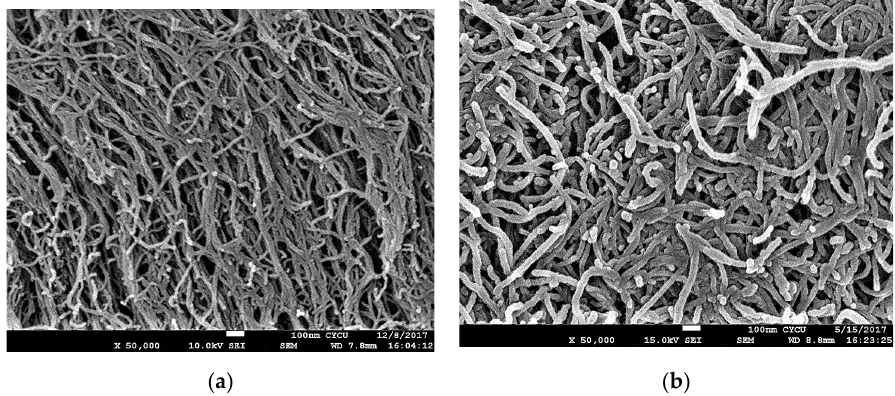
Figure 1. Morphologies of multi-walled carbon nanotubes (MWCNTs). ( a ) high aspect ratio MWCNTs, ( b ) low aspect ratio MWCNTs.